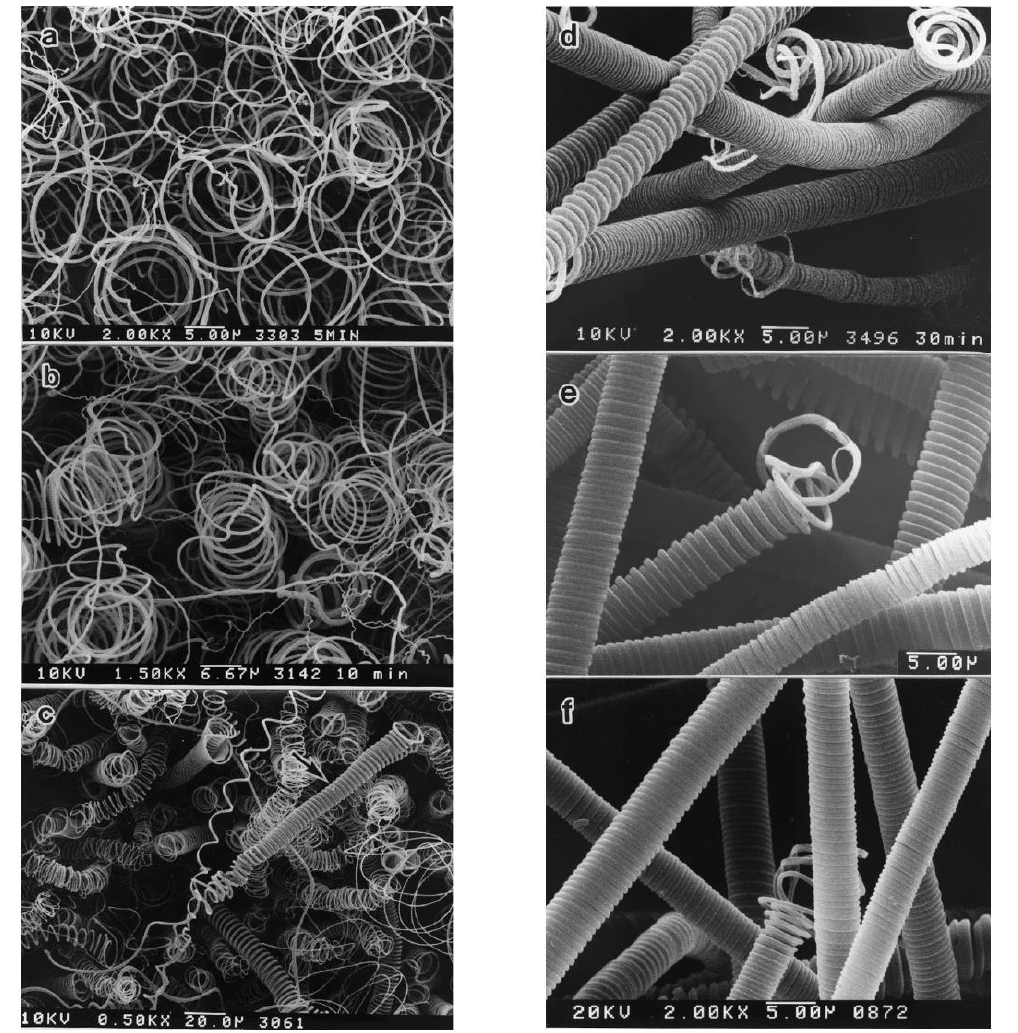
Figure 7. Growth stages of carbon coils. Reaction time: ( a ) 5 min; ( b ) 10 min; ( c ) 15 min; ( d ) 30 min; ( e ) 60 min; and ( f ) 120 min ([112], Chen and Motojima,